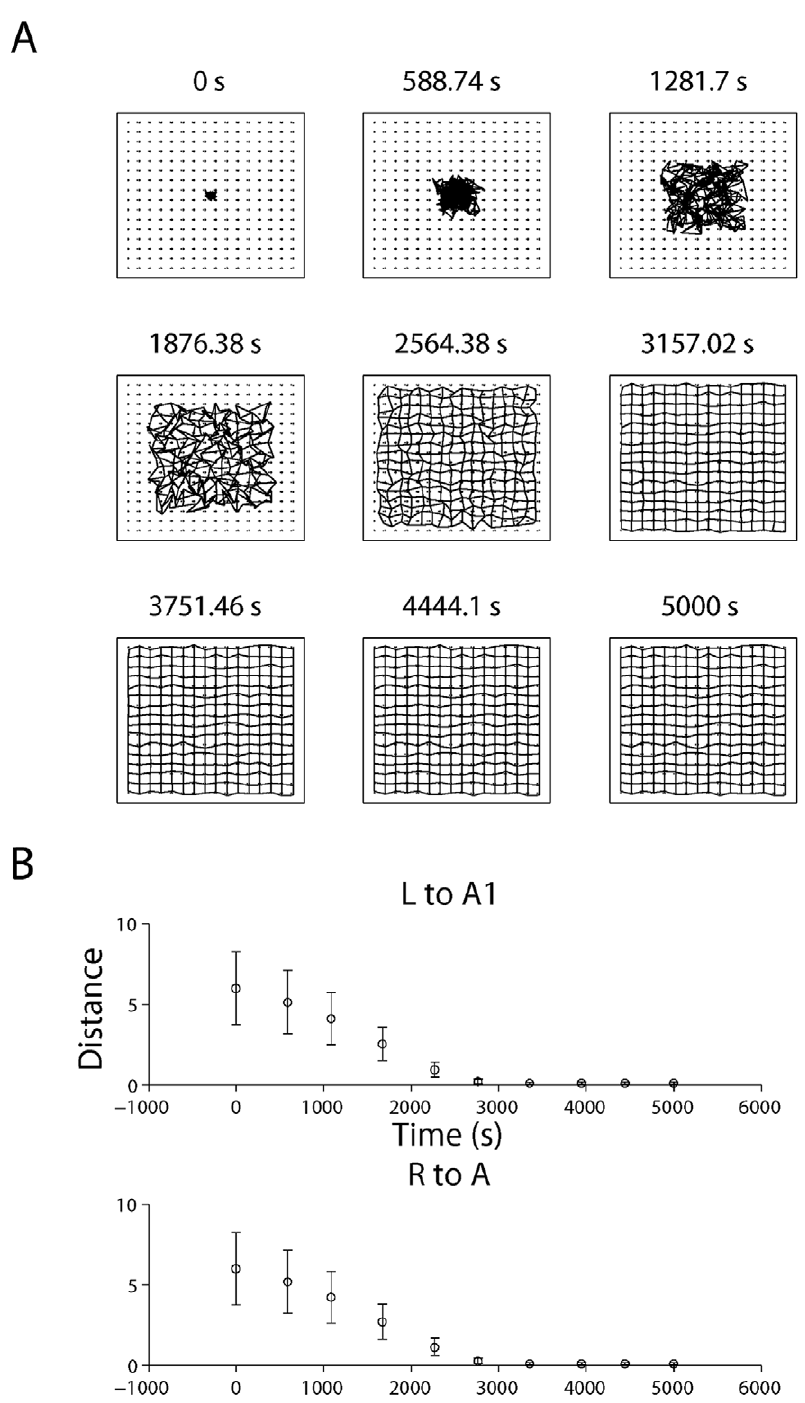
Figure 10. Retinogeniculate development accelerates as wave velocity and wave frequency increases by increasing B R (see Figure 4). (A) The CoMs approach the ideal grid at a faster pace with accelerated waves, also shown by the sharper decrease in the mean distance of the CoM from their targets (B).